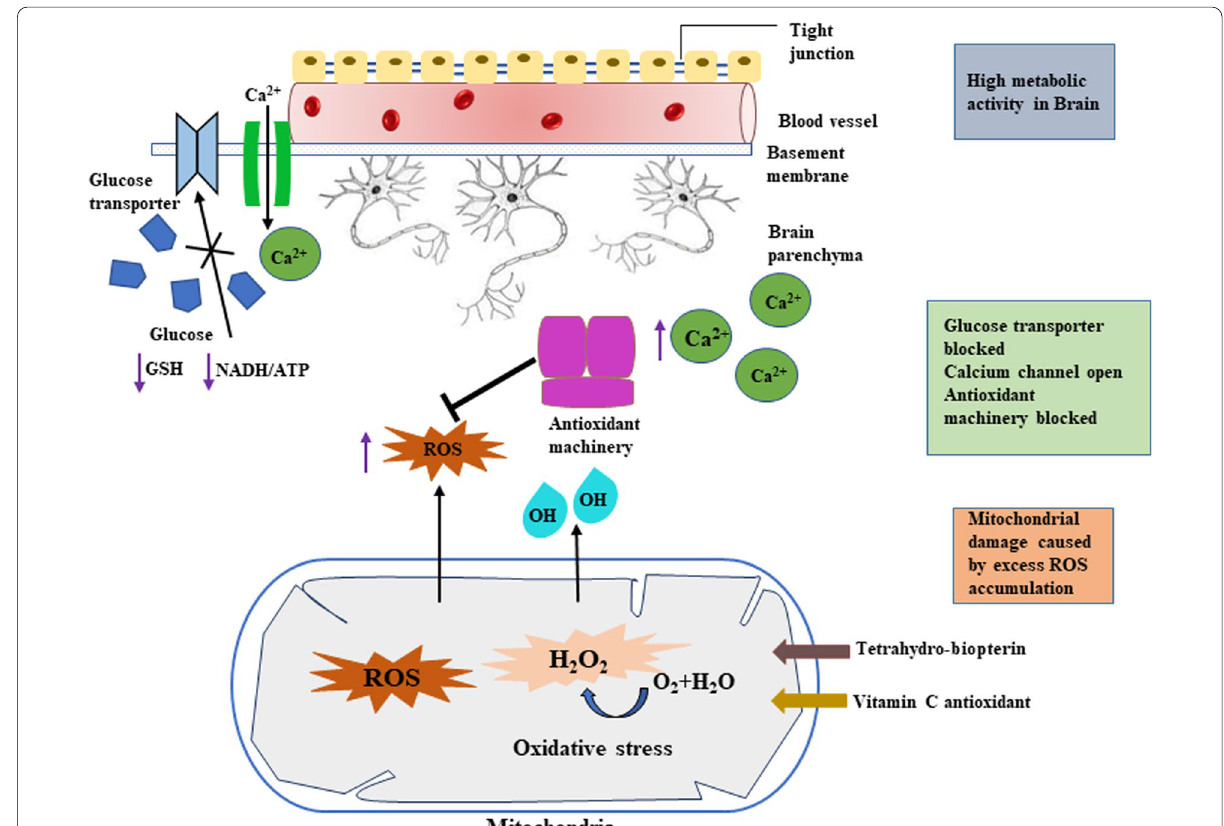
Fig. 2 Schematic diagram showing interaction of Mitochondrial ROS and Brain activity in Autism Spectrum Disorder (ASD)